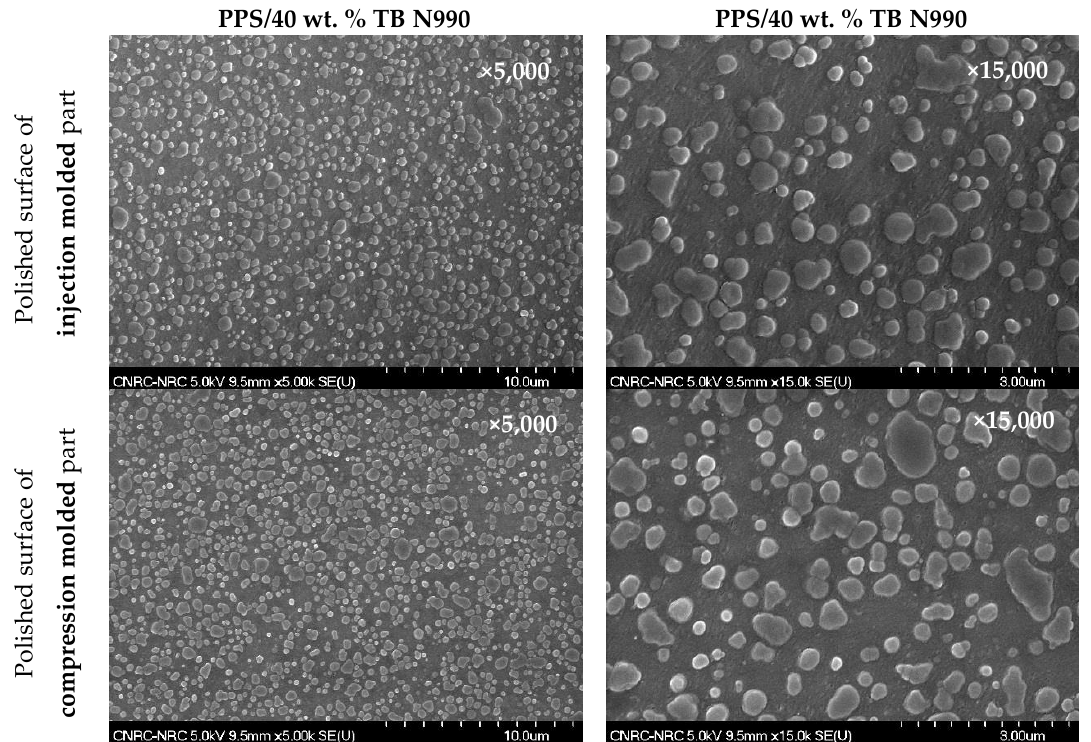
Figure 8. SEM morphologies of polished surfaces of injection molded (1st row) and compression molded (2nd row) of PPS / 40 wt. % TB N990 compounds.